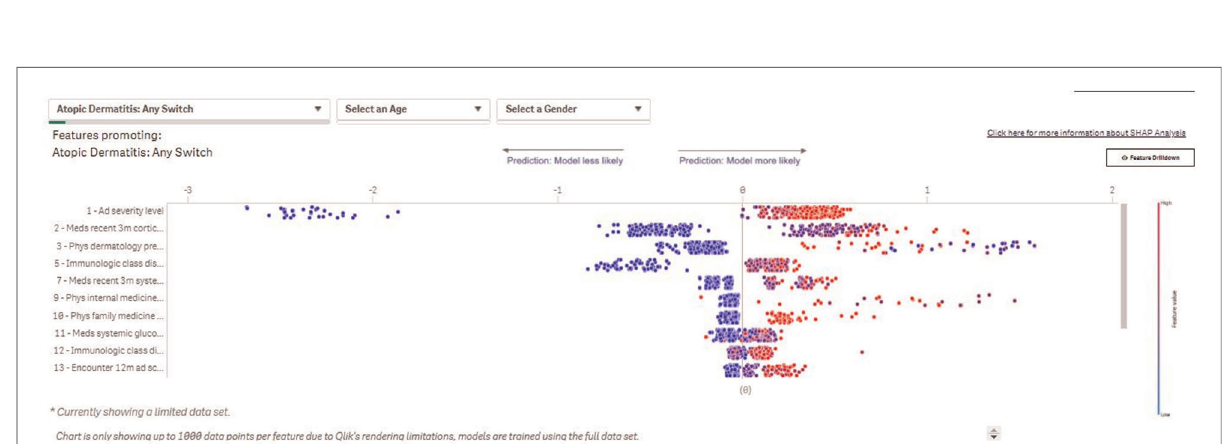
FIGURE 3 Treatment Journey of all patients in Immunolab from any treatment they are receiving to systemic corticosteroids. Note: The PJM provides user- friendly visual output in the form of Sankey plots, describing the use of drug classes across lines of therapy for patient subpopulations of interest. IgE, Immunoglobulin E; IL, interleukin; PJM, Patient Journey Mapper.